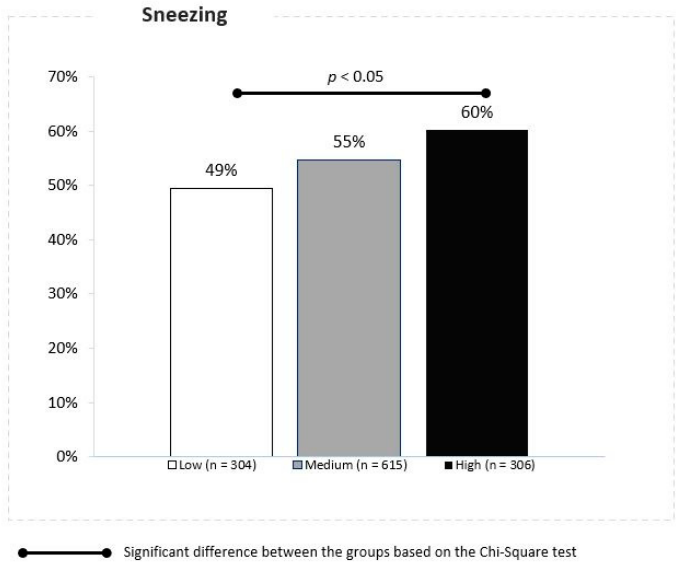
Figure 4. Association between the PM 10 concentrations and sneezing. The difference in the occurrence of hoarseness (34% vs. 36%) and sore throat (30% vs. 33%) in children living in cities with low vs. high daily mean PM10 concentrations was statistically insignificant (Chi-Square test).